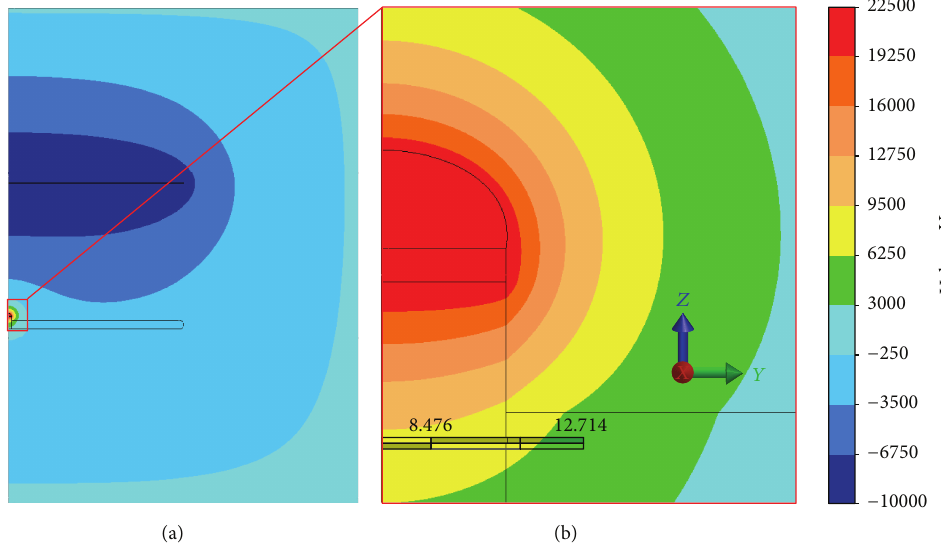
Figure 6: Analysis results: (a) graphical distribution of potential and (b) detailed view on the tip of the rod electrode.